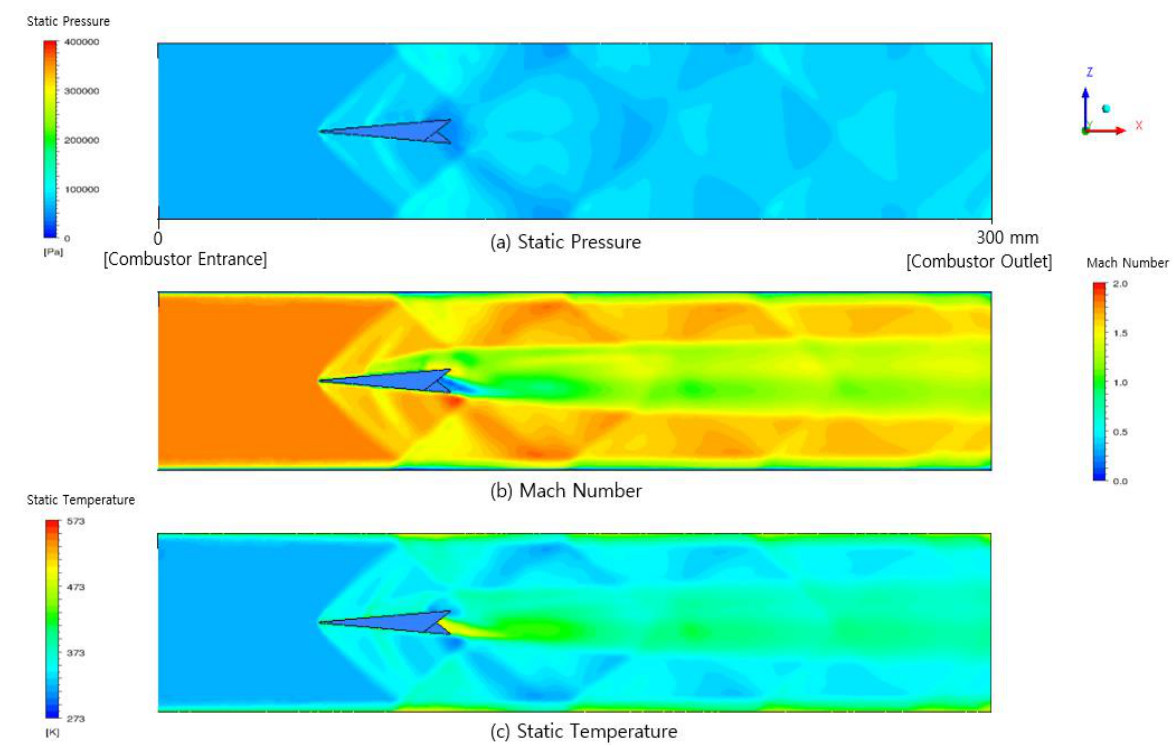
9 of 19 Figure 2. Comparison of static pressures along the center of combustor top wall for three different grids with experimental data [33]. Figure 3 shows the static pressure, Mach number, and static temperature contours in the X-Z plane at mid-height in the Y direction of the combustor for an air temperature of 523 K. It can be seen that an oblique shock was generated ahead of the pylon, which hit